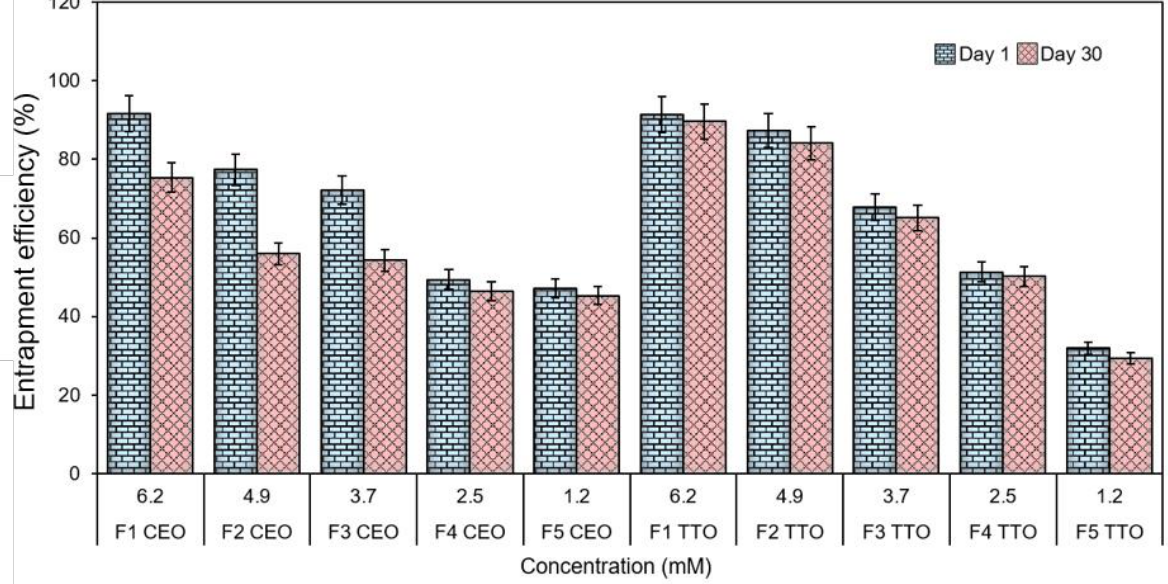
Figure 3. Percent EE of CEO and TTO nanoliposomes at day 1 and day 30 after preparation.